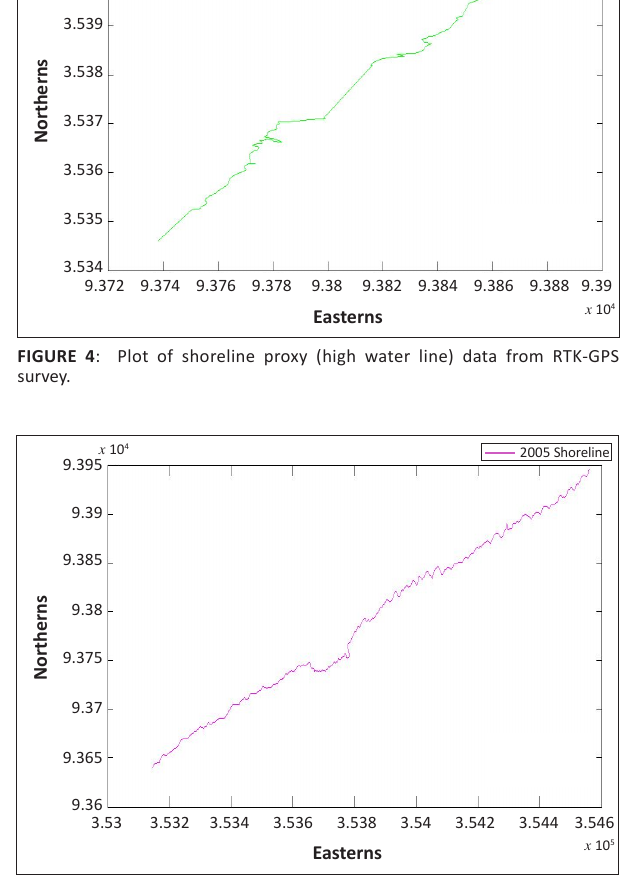
FIGURE 5 : Plot of historical shoreline (high water line) obtained from the 2005